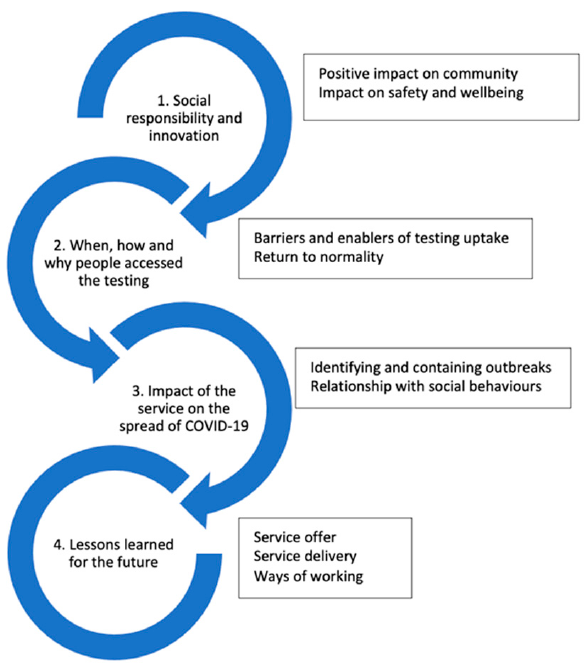
Figure 2. Overarching themes and sub-themes.